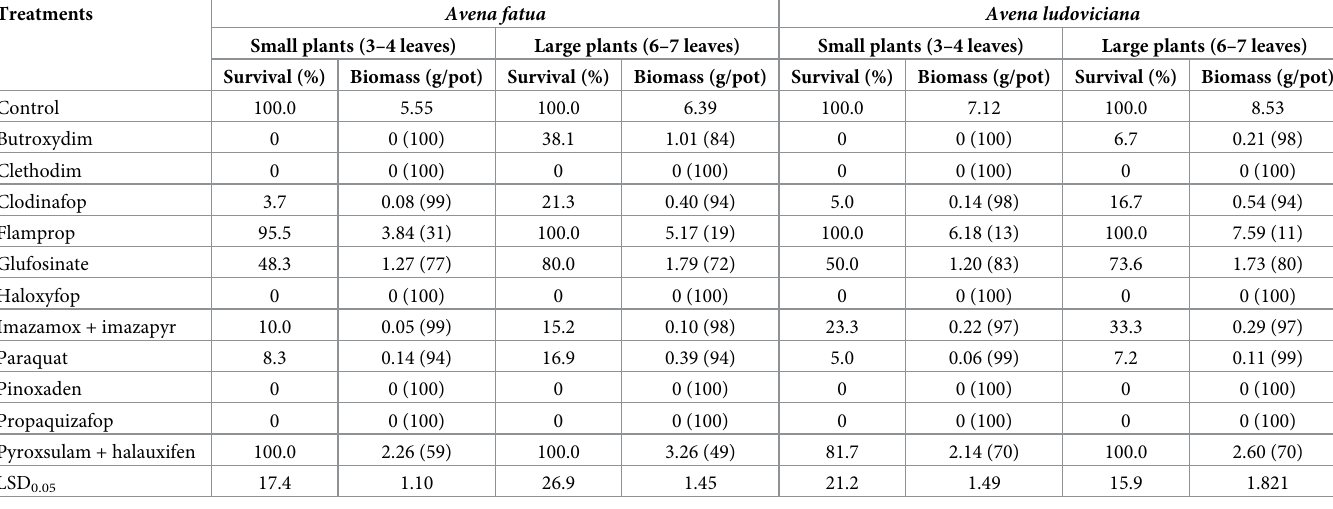
Values in parentheses are percent reductions of their respective nontreated control